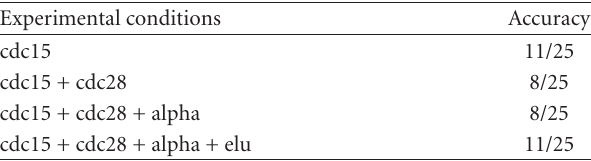
Table 4: Result on inference of a yeast cell cycle